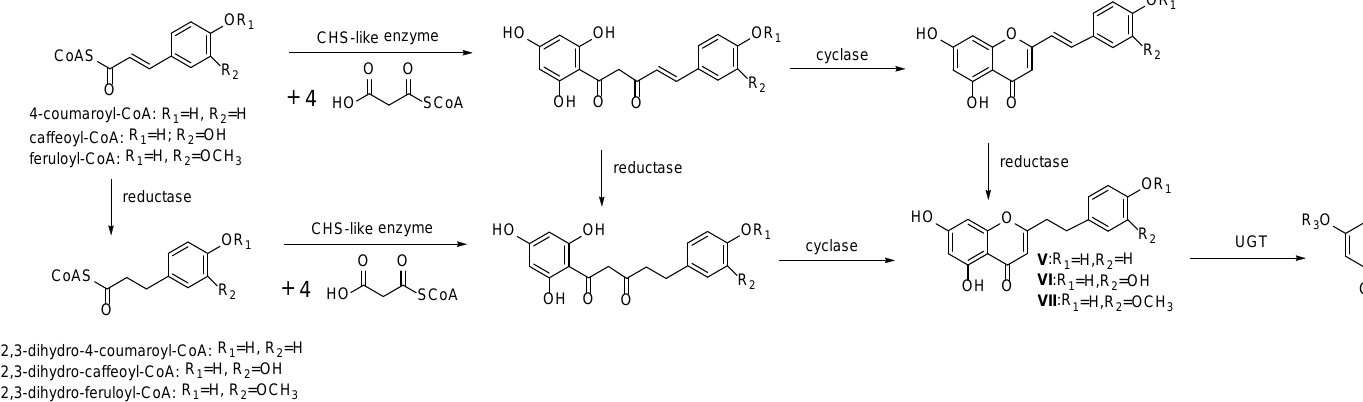
VIII :R 1 =H,R 2 =H,R 3 =glycosyl